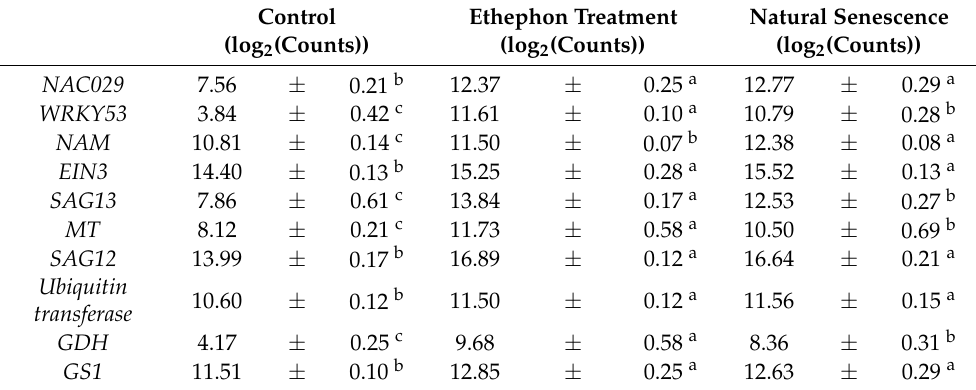
Table 2. Mean log 2 gene counts ± standard deviation of the examined SAGs in leaves of control, ethephon-treated, and naturally senescing Vitis vinifera cv. Riesling vines ( n =